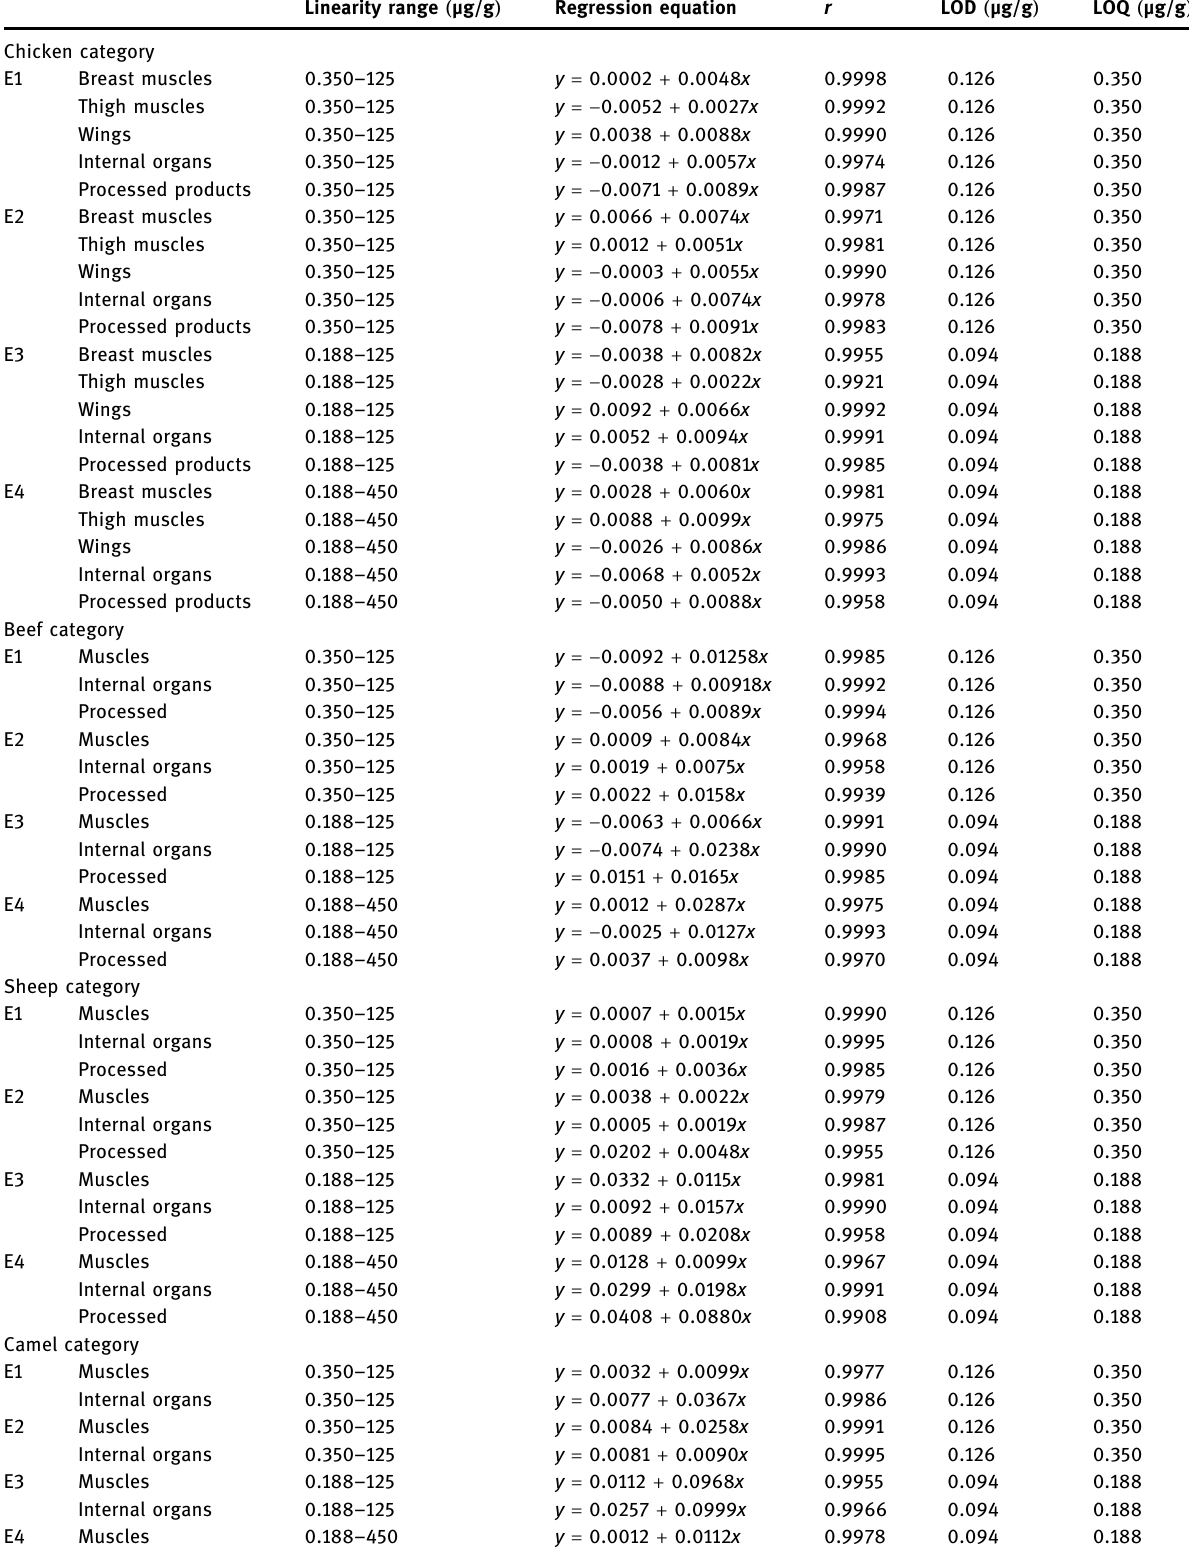
Table 1: Matrix - based calibration parameters for the determination of estrogens in di ff erent meat categories using the proposed HPLC - DAD